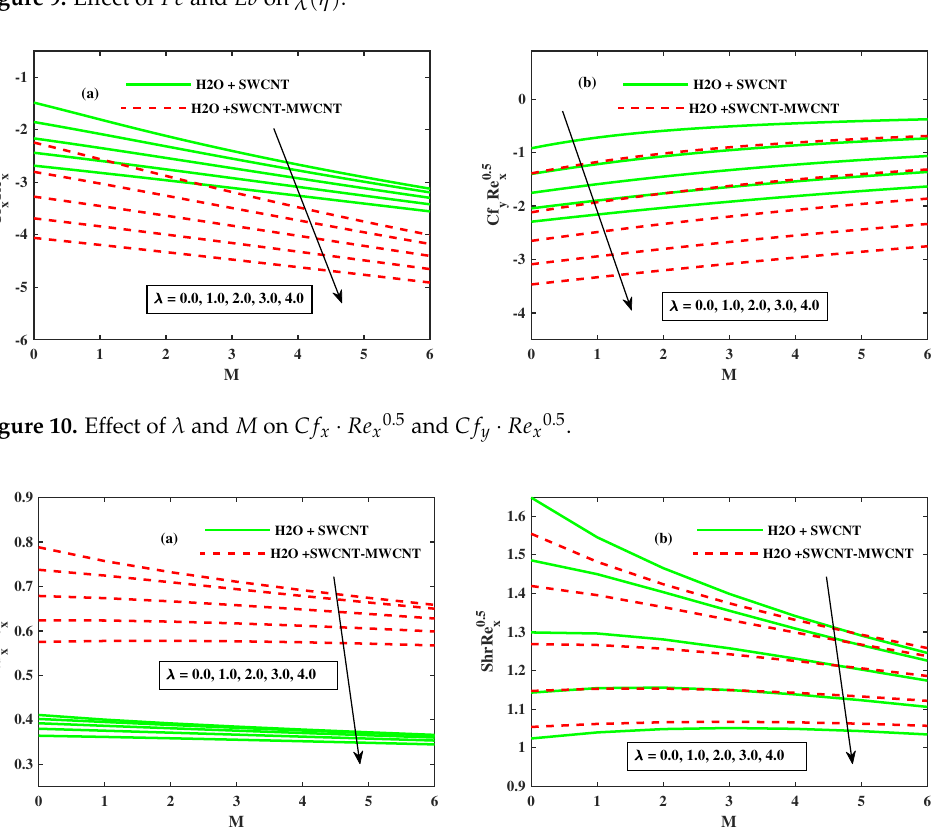
Figure 11. Effect of λ and M on Nu x · Re x − 0.5 and Shr x · Re x 0.5